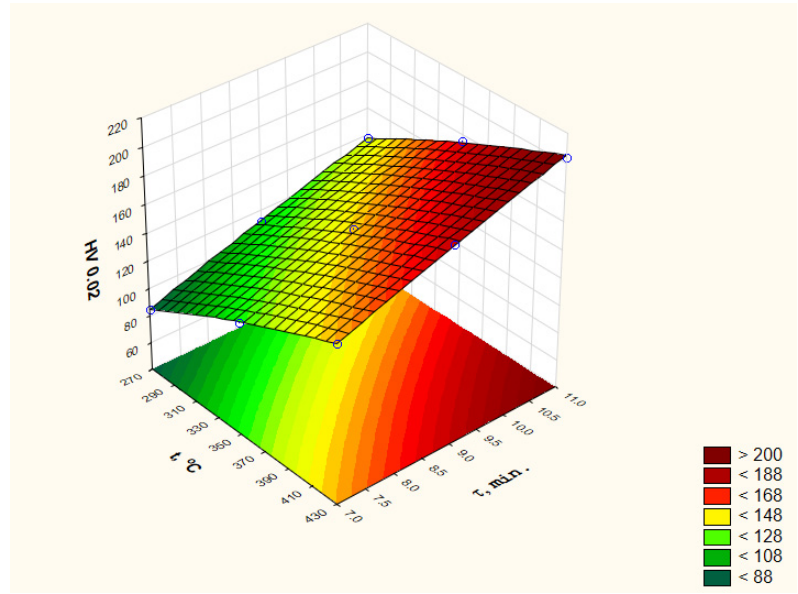
Figure 3. Influence of the heat treatment parameters on the microhardness of the zinc coating deposited on the head of M12 × 60 bolts—determined with “Statistica” software.